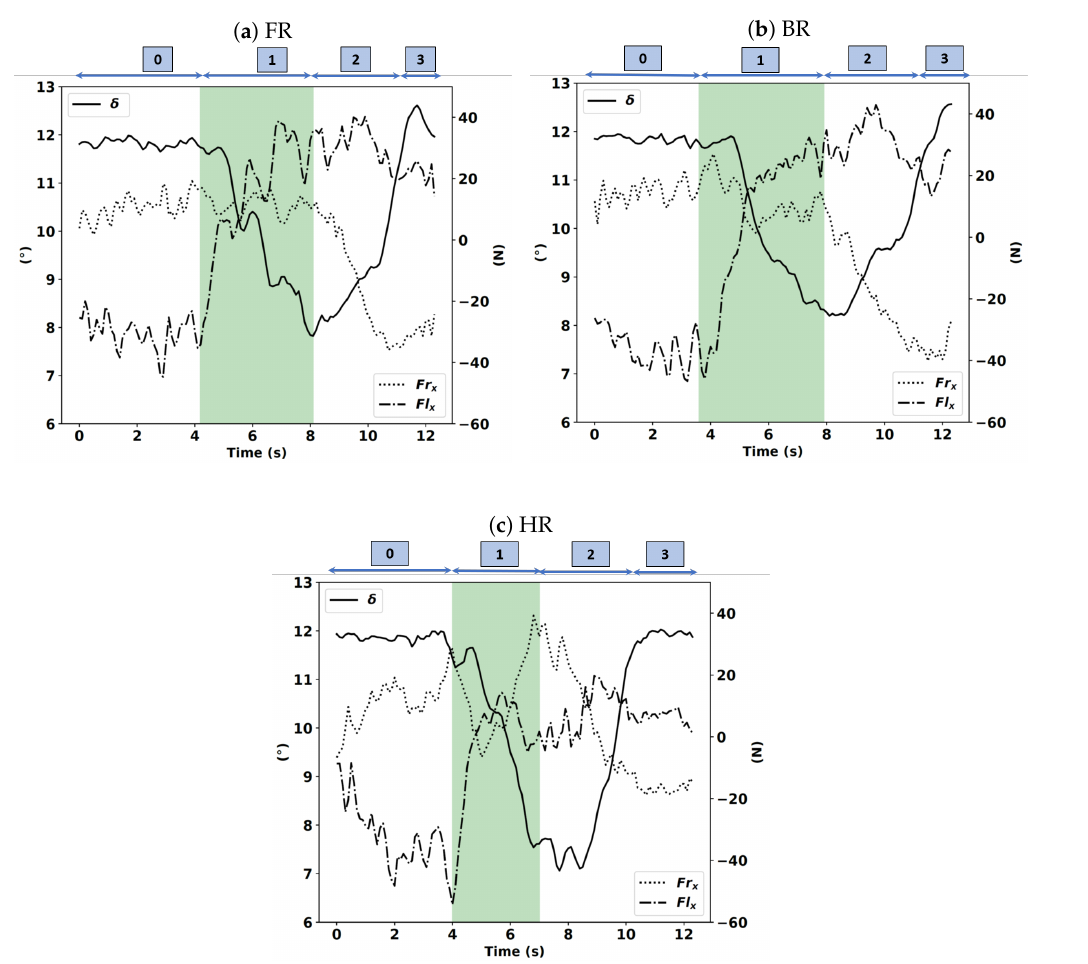
Figure 12. Applied forces on the left (Flx) and right (Frx) handlebars along the longitudinal axis expressed in newtons (N), and the handlebar steering angle ( δ ) expressed in newtons (°) in the FR, BR, and HR